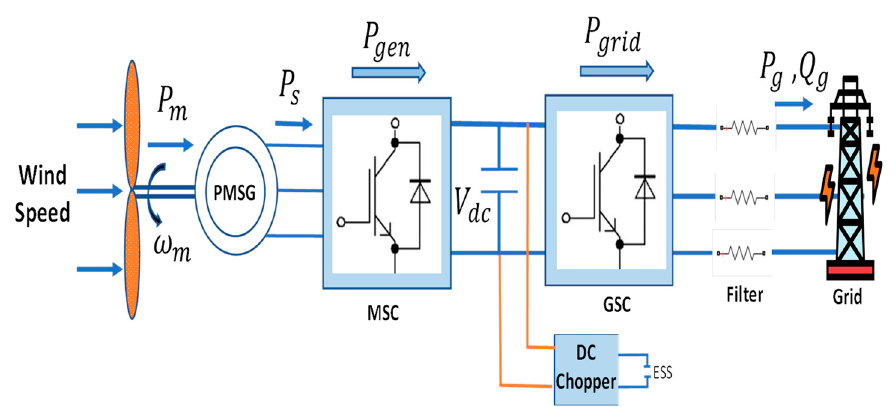
Figure 18. EES linked to a DC link to boost PMSG-based WECS LVRT.